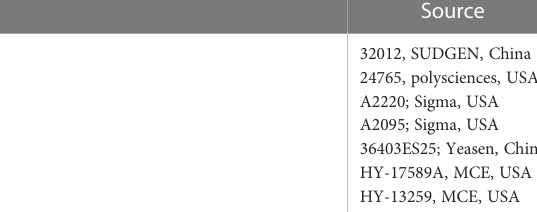
TABLE 3 Reagents used in this study. Reagent Lipomax Polyethylenimine (PEI) Mouse anti-Flag protein A/G agarose beads Mouse anti-HA protein A/G agarose beads protein A/G agarose beads Chloroquine (CQ)